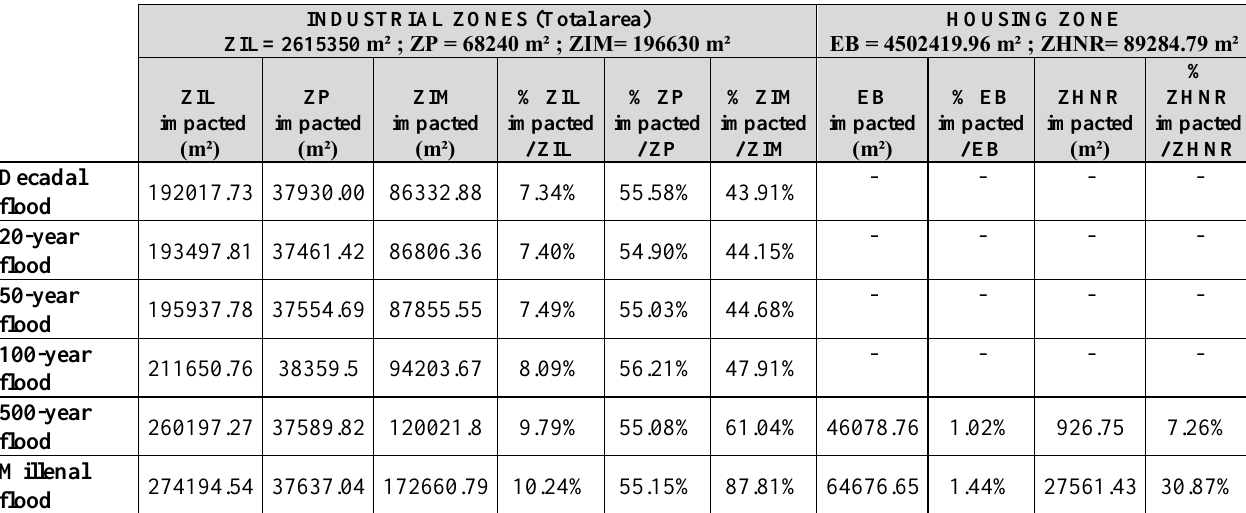
Table 1. Areas affected by floods at different return